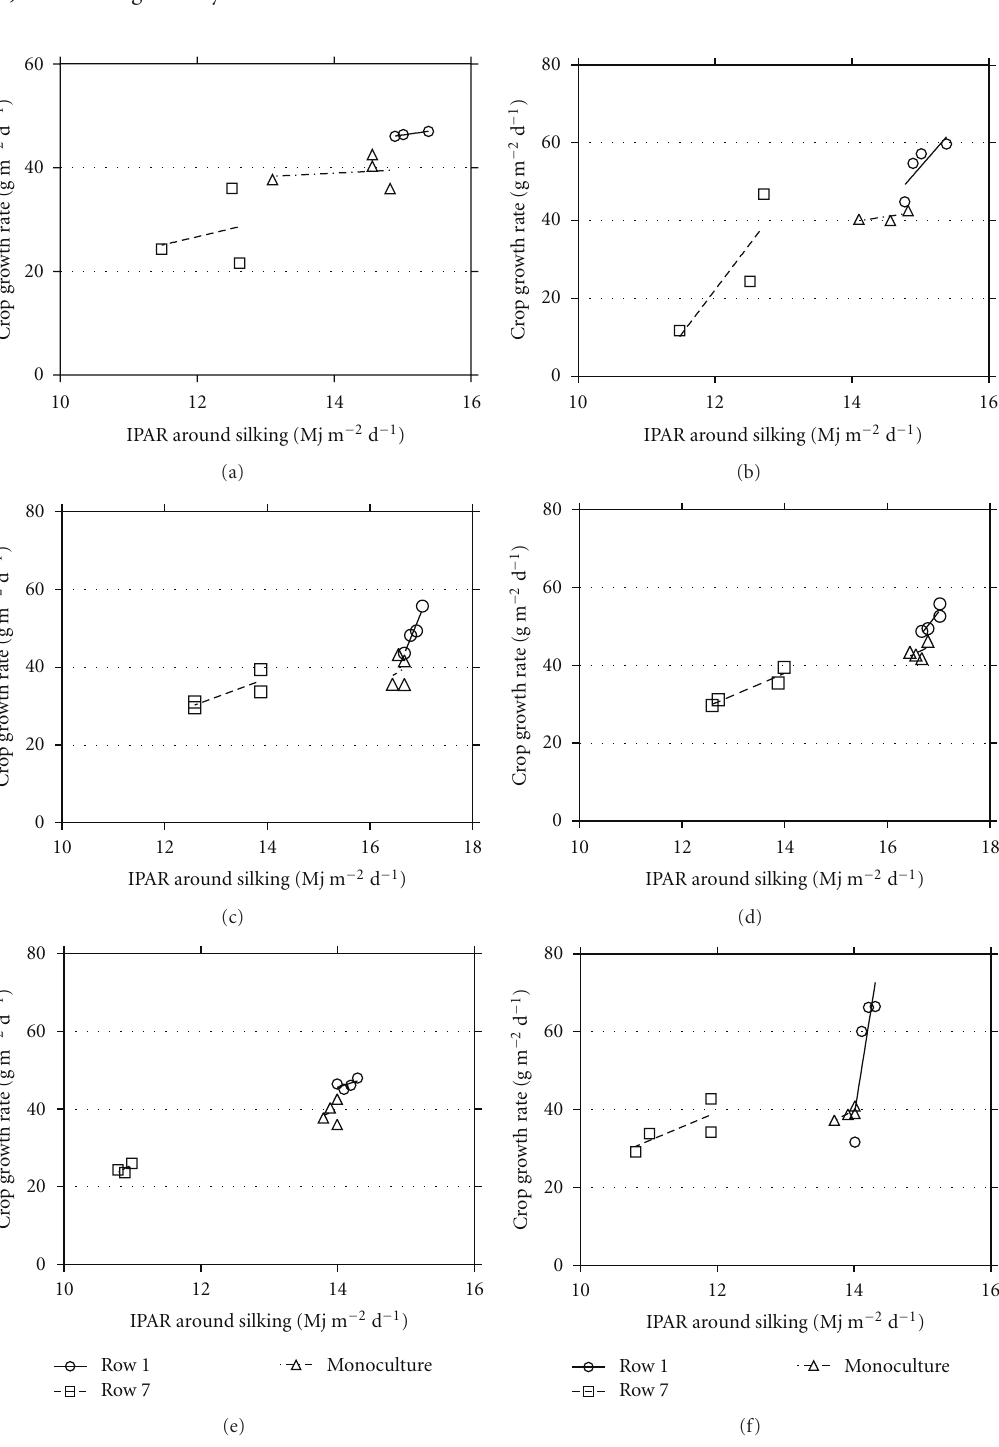
However, total biomass versus IPAR during C1 (Figures 3(a) and 3(b)) was significantly lower than during C2 (Figures 3(c) and 3(d)) and C3 (Figures 3(e) and 3(f)). High RUE is crucial to maximizing crop e ffi ciency. In corn, RUE values ranged from 3 to 4 g MJ − 1 . Although plants